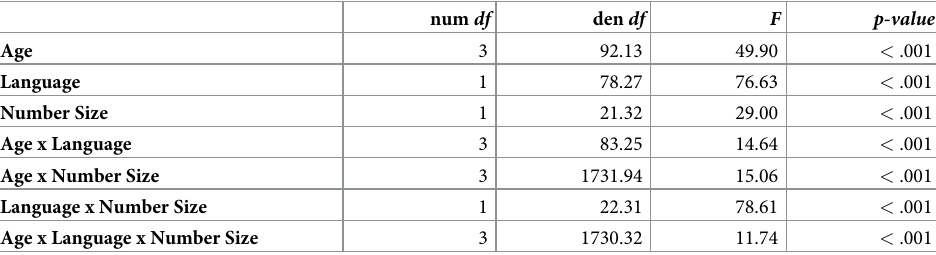
Table 3. Results of the verbal-visual matching task’s RT’s linear mixed model.